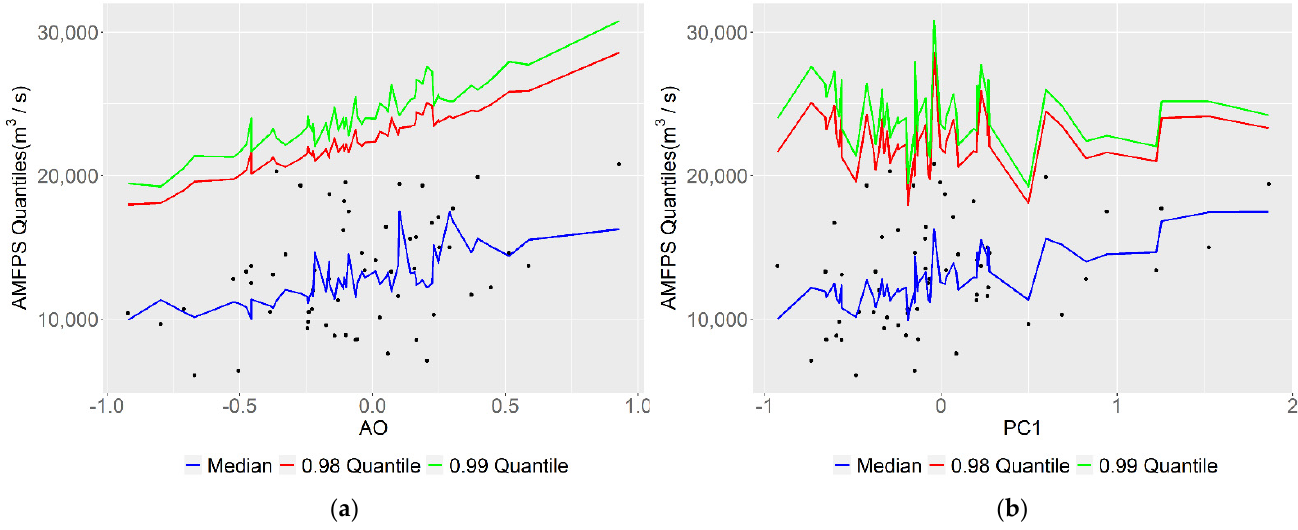
Figure 8. The median, 0.95 and 0.99, quantiles of AMFP plotted against JJA AO ( a ) and JJA SLPa2- PC1 ( b ).